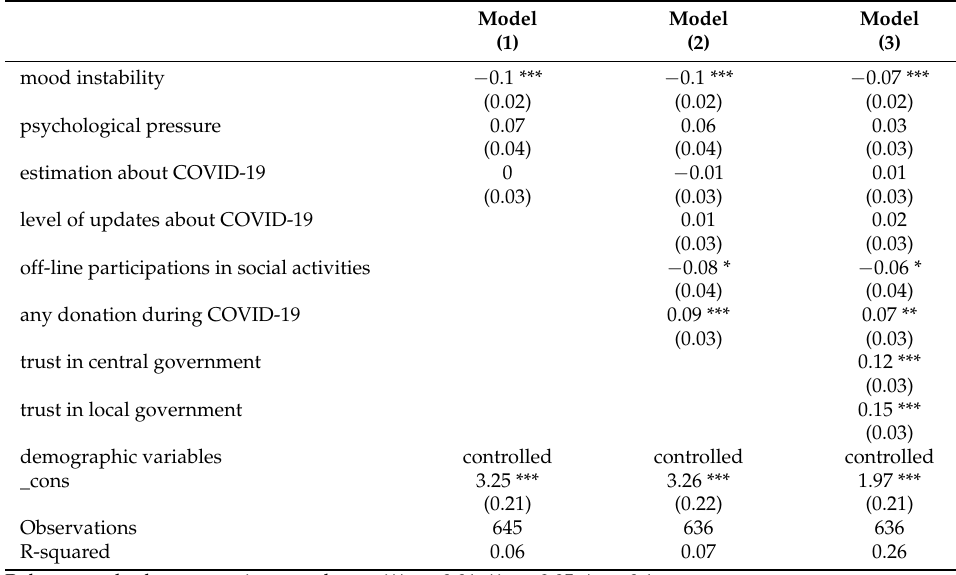
Table A3. Multiple Regression Analysis of